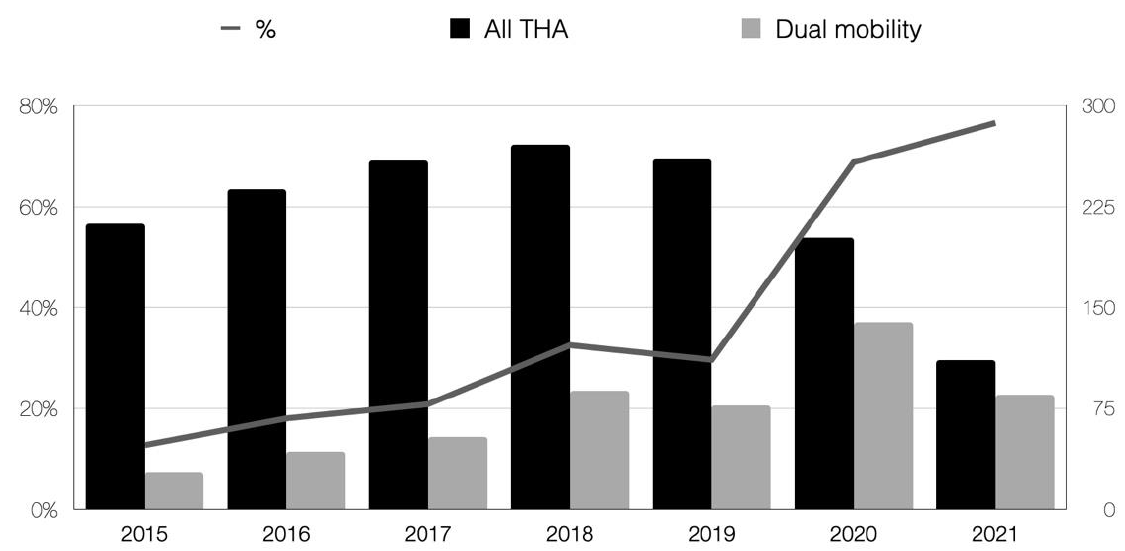
Figure 1. Trend in the indications for total hip replacements with dual mobility cups in our depart- ment as a comparison with the total amount of total hip replacements performed. The line shows the proportion. Table 1. Summary of all patients sustaining a dislocation.